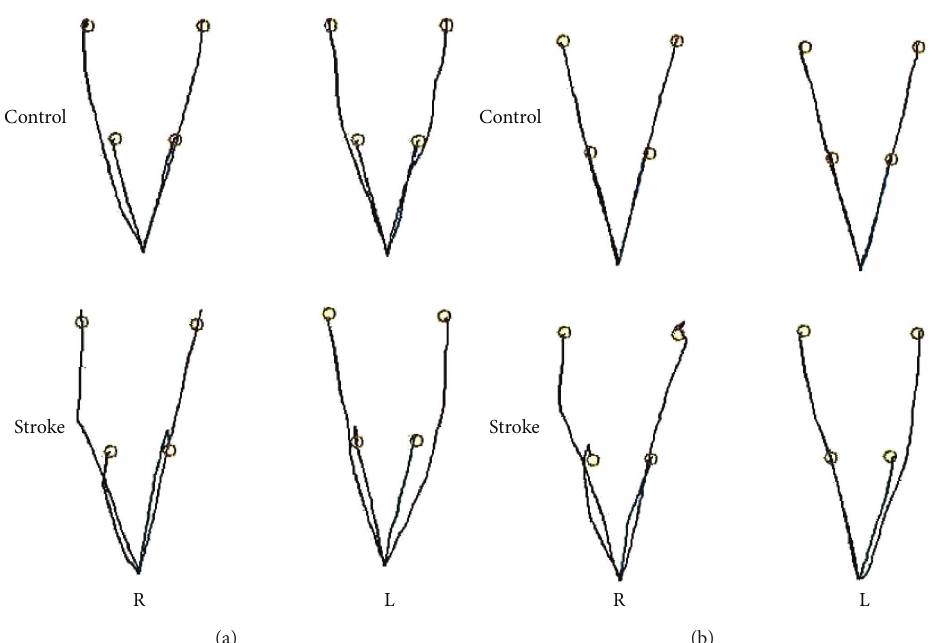
Figure 2: Trajectory profile from a representative participant of each group with the right (R) and left (L) arms for the two targets (0.8 and 1.6cm) and two distances from the initial position (9 and 18 cm) used in the experiment.